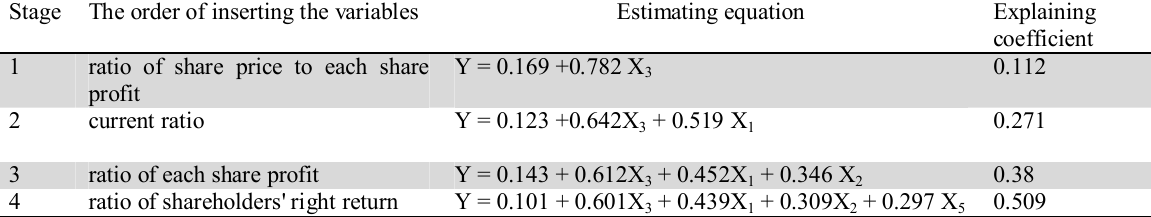
The order of inserting the data in the stepwise regression